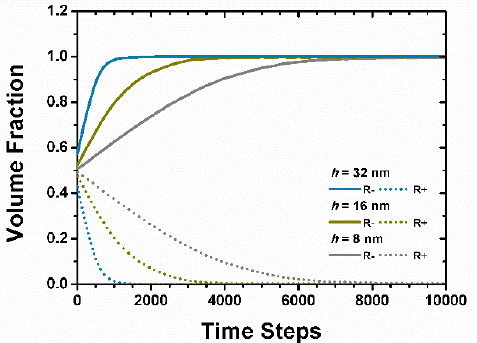
Figure 3. Time evolution of volume fractions for downward (R- with solid line) and upward (R+ with dot line) variants. Films with different thicknesses (32, 16, and 8 nm) are indicated with different colors.